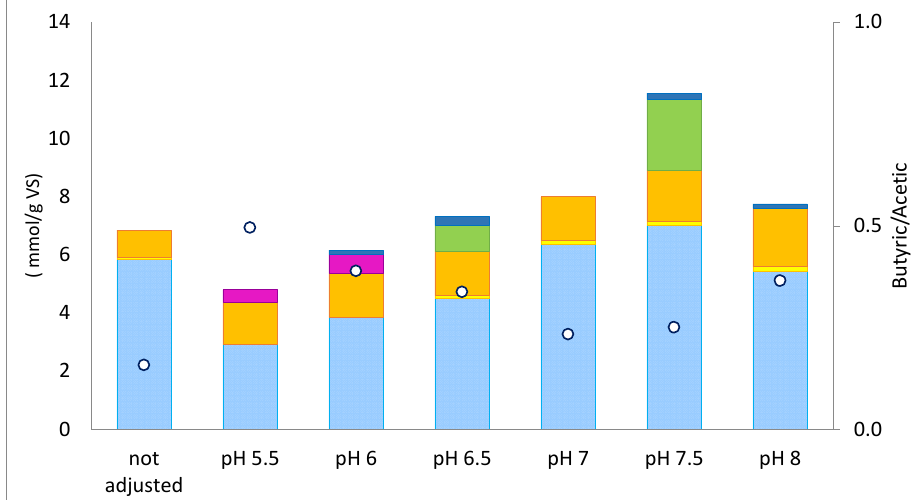
Table 5. Statistical analysis of the three compared models describing H 2 production with seven dif- ferent initial pH conditions.